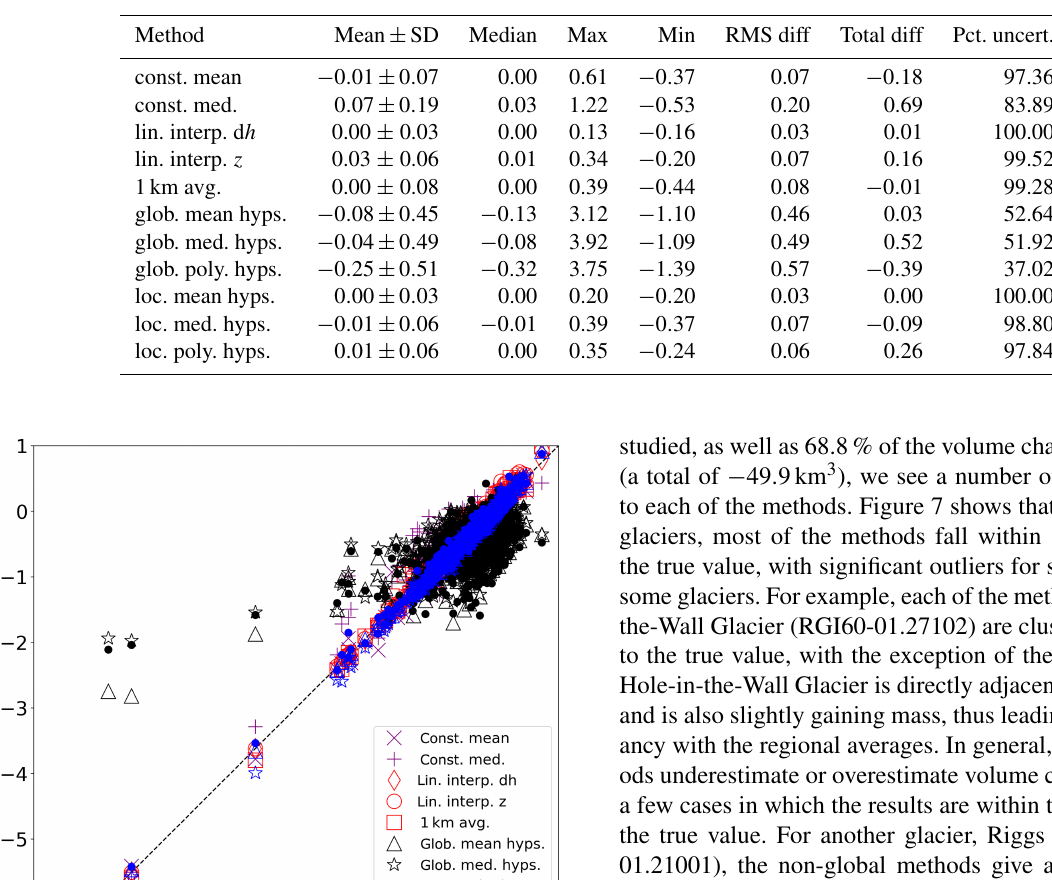
Table 1. Summary statistics for difference to true volume change for each method for the 415 glaciers sampled. Here, SD refers to standard deviation, and “diff” refers to the difference to true volume change (i.e., interpolated–true). All units in ma − 1 , except for “total diff”, which is in units of km 3 a − 1 , and “pct. uncert.”, which indicates the percentage of glaciers for which the interpolated dV was within the uncertainty of the true volume change.